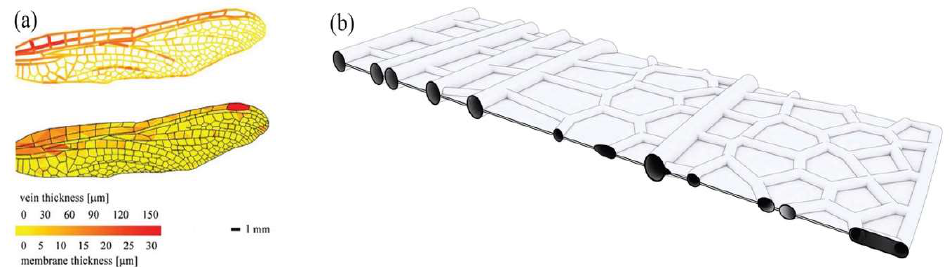
Figure 6. The forewing of the dragonfly features a distinct stiffness distribution ( a ) with thicker veins and membranes shown in red and a sandwich micro-structure shown in cross-section ( b ).